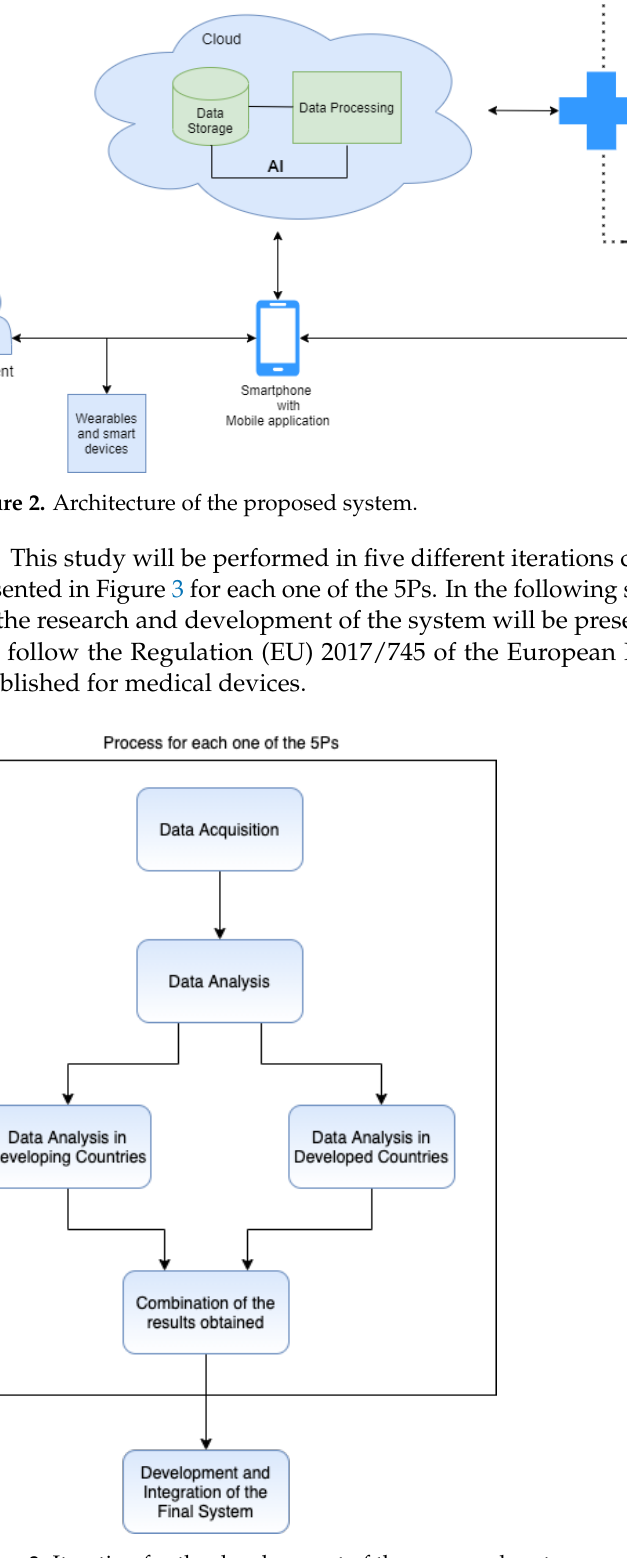
Figure 3. Iteration for the development of the proposed